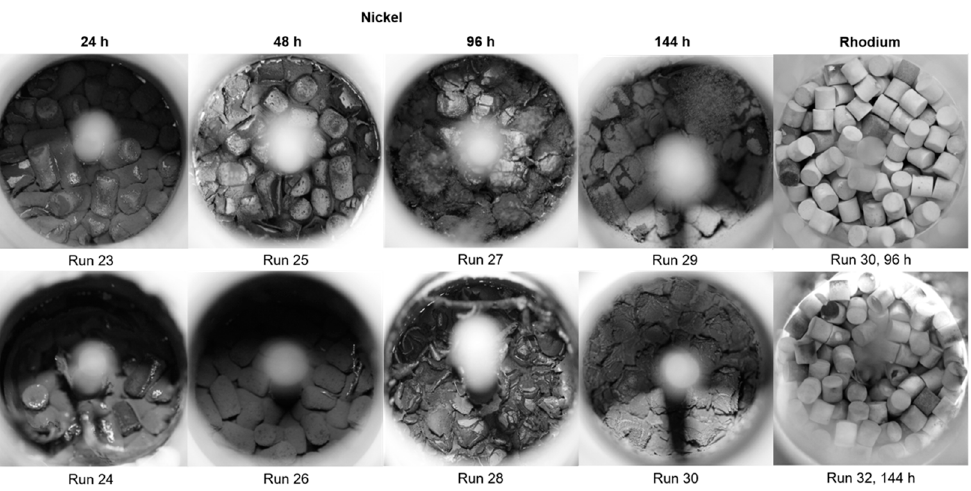
Figure 7. Top view of the reactor after each TOS test run with nickel and rhodium catalysts.